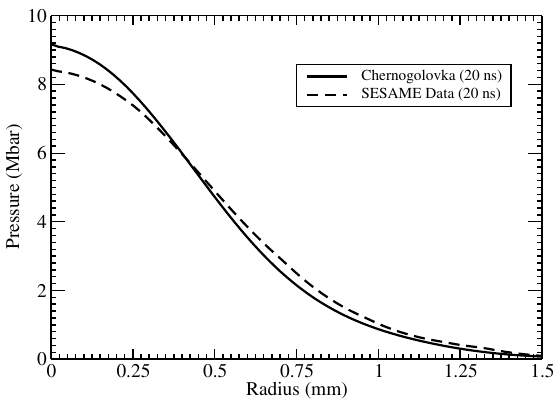
FIG. 18. Pressure vs radius at t (cid:3) 20 ns , using the beam and target parameters shown in Fig. 5, but using two different equation-of-state models, namely, SESAME and a semiempir- ical model.